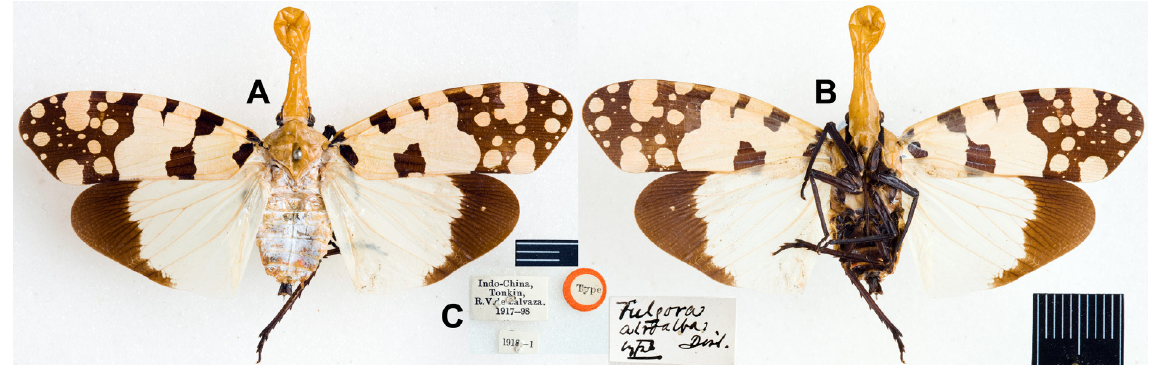
Fig. 5. Pyrops atroalbus (Distant, 1918) comb. nov., holotype ♂ (BMNH, photographs by D. Croucher). A . Habitus, dorsal view. B . Habitus, ventral view. C